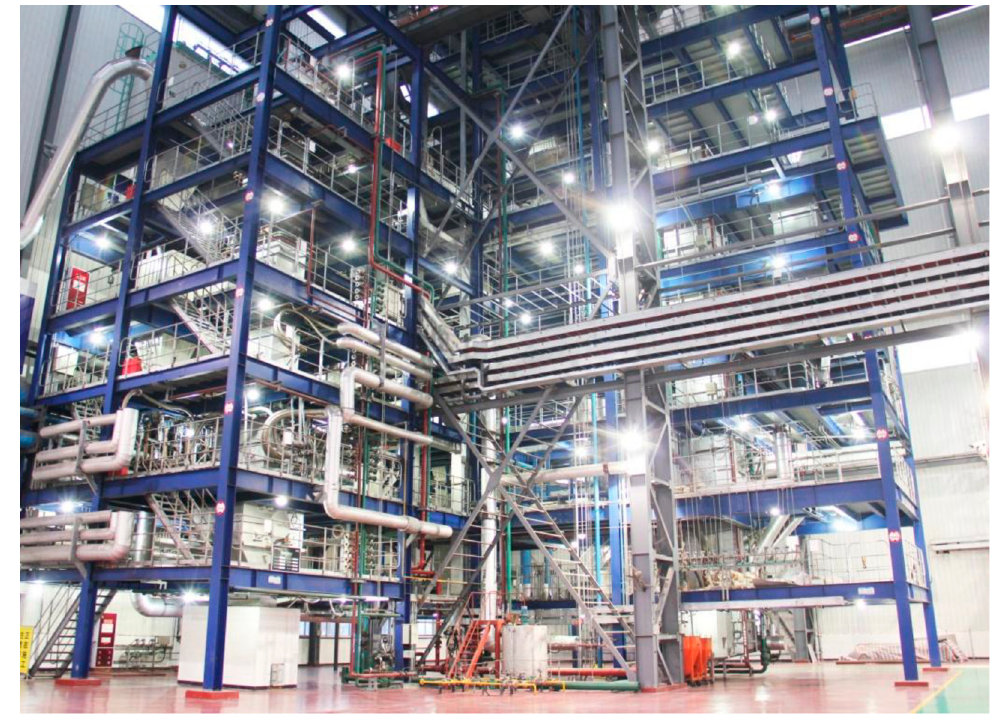
Figure 3. Dongfang boiler 3-MW circulating fluidized bed combustion test bench.